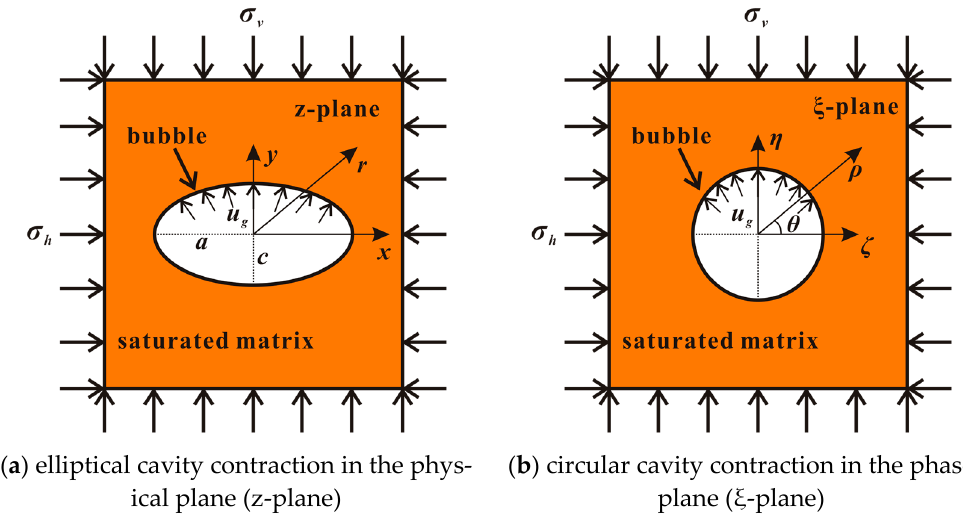
Figure 8. Schematic diagram of 2D undrained elliptical bubble contraction(redrawn from [44]). Using the conformal mapping technique, the stress around an elliptic cavity in the physical plane can be transformed by available solutions for stresses near a circular cavity in the phase plane (i.e., ρ - θ plane, where ρ radius of the circular bubble and θ the angle between the ζ axis and ρ axis).